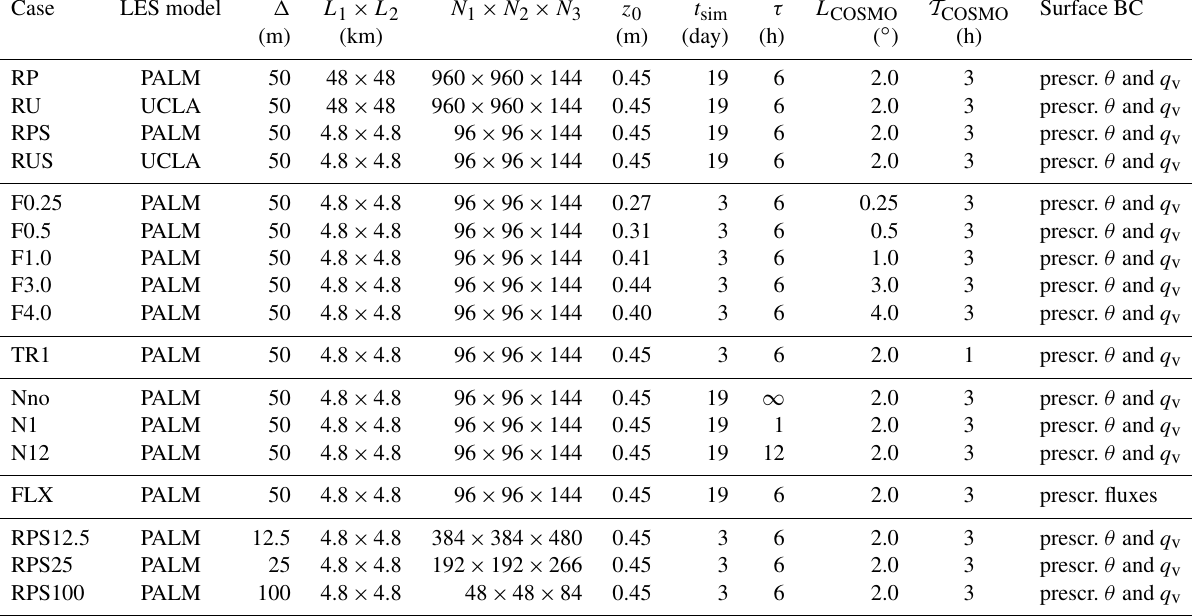
Table 5. Parameters of the simulated